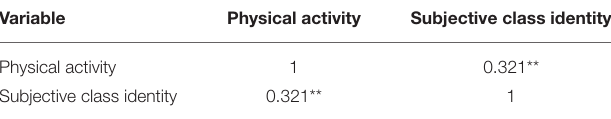
TABLE 3 | Correlation between